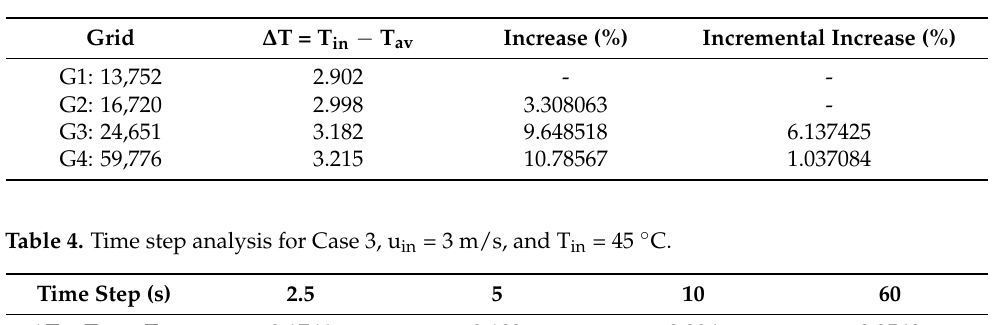
Figure 2. Comparison of the flow structure with the results of References [29,30].